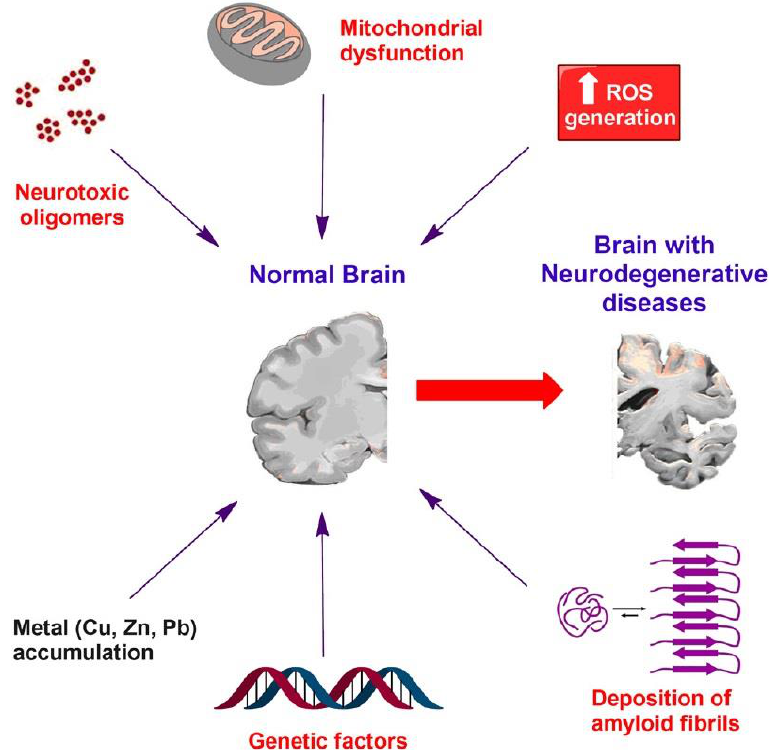
Figure 1. The multifactorial and complex nature of neurodegenerative diseases. Various mechanisms of neurodegeneration are proposed i.e., metal accumulation, neurotoxic oligomers, mitochondrial dysfunction, genetic factors, ROS (reactive oxygen species), and deposition of amyloid fibrils [25]. Reprinted from Ibrahim and Gabr. Copyright © 2019 Neural Regeneration Research was published by Wolters Kluwer Medknow Publications under Creative Commons Attribution-NonCommercial-ShareAlike License (CC BY-NC-SA).